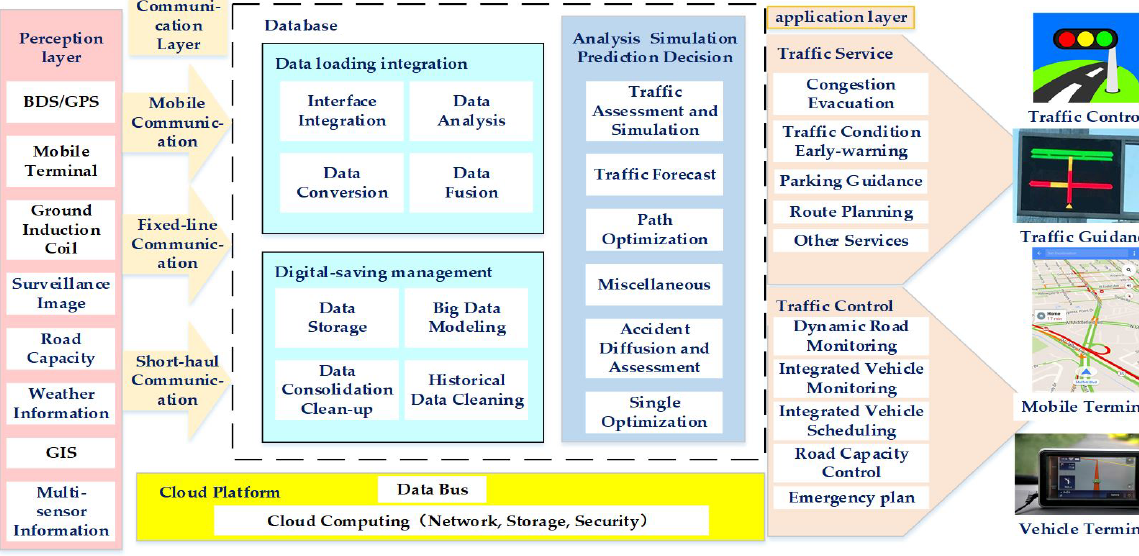
Figure 14. The architecture of the intelligent transportation system (ITS).